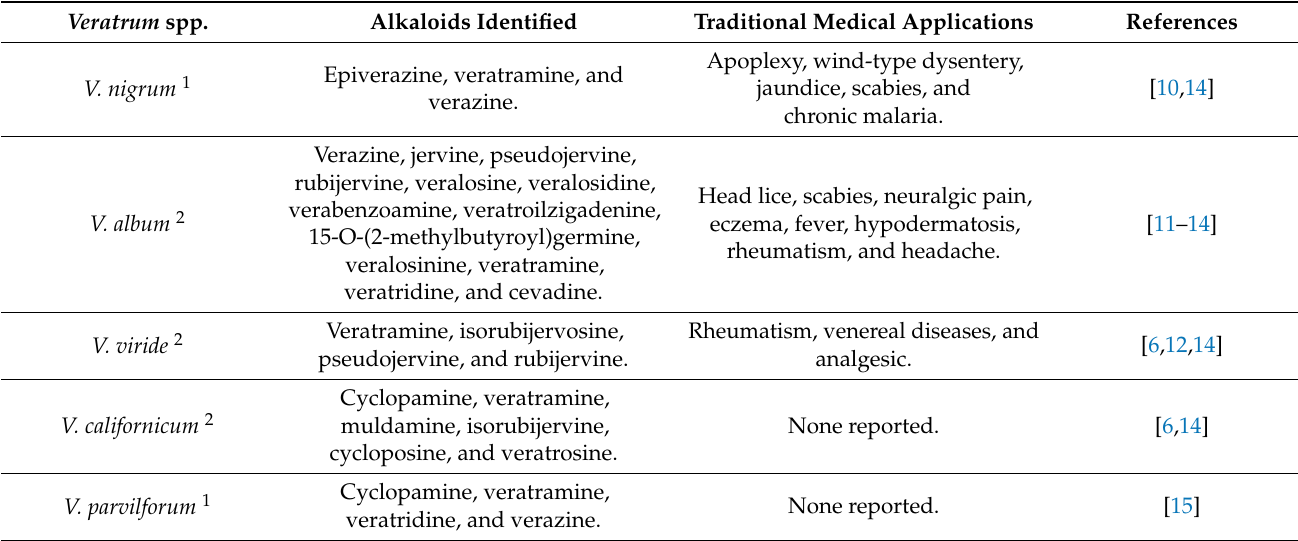
Table 1. A comparison of the identified steroidal alkaloids and traditional medicinal applications for several Veratrum